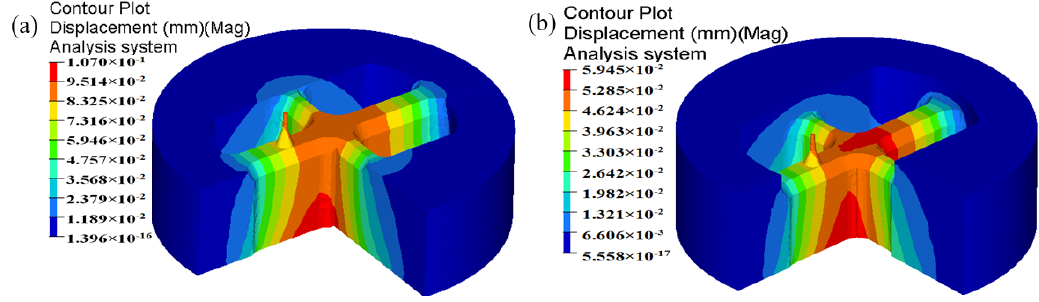
Figure 19. The displacement distribution in the upper die ( a ) the initial design scheme and ( b ) the optimal design scheme.